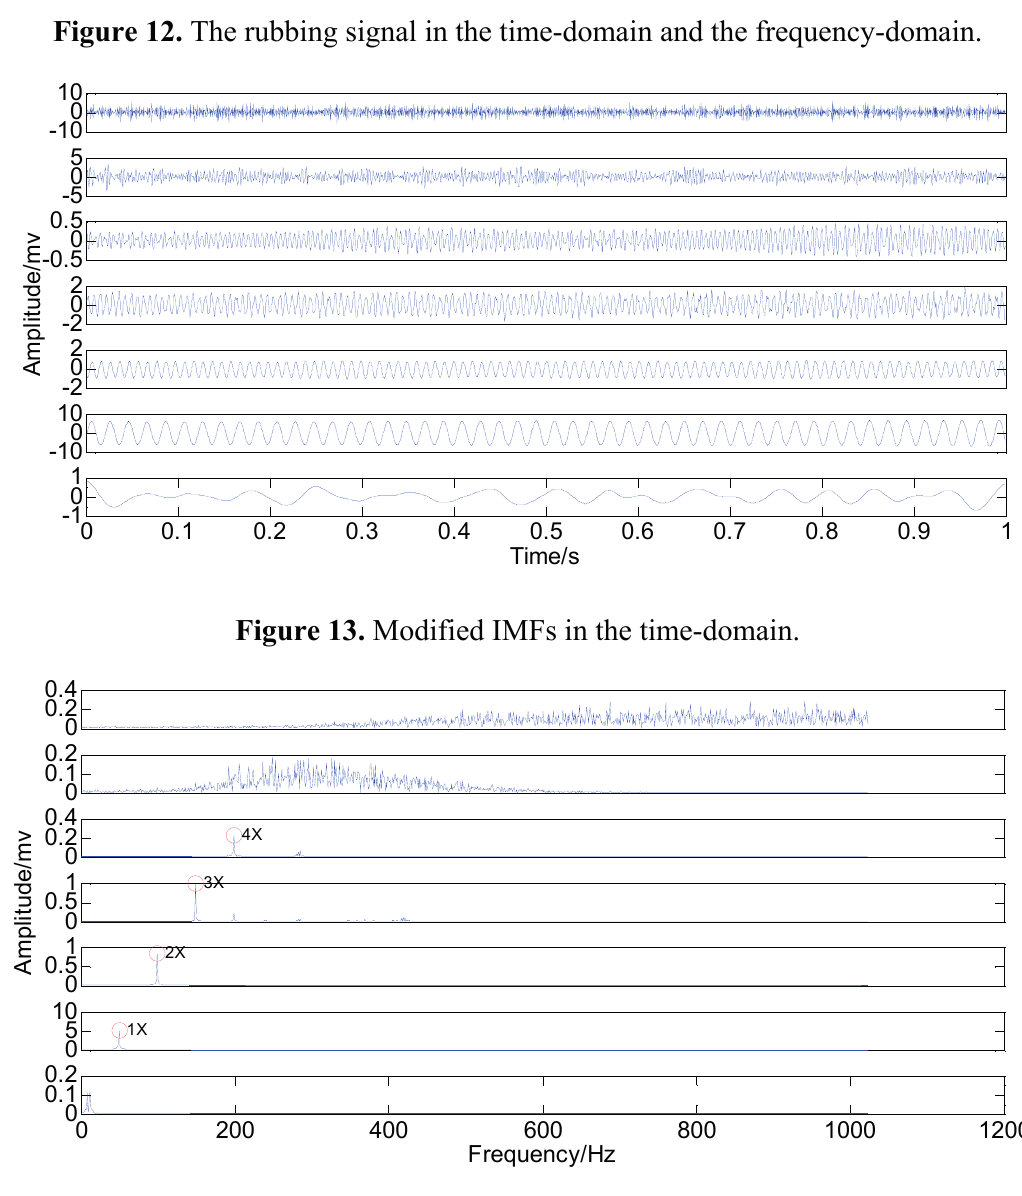
Figure 14. Modified IMFs in the